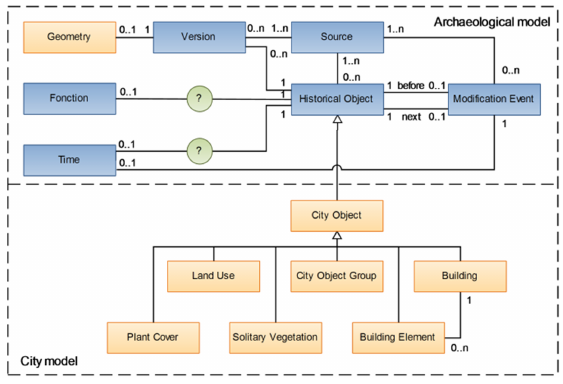
Figure 6. Virtual Leodium information UML model